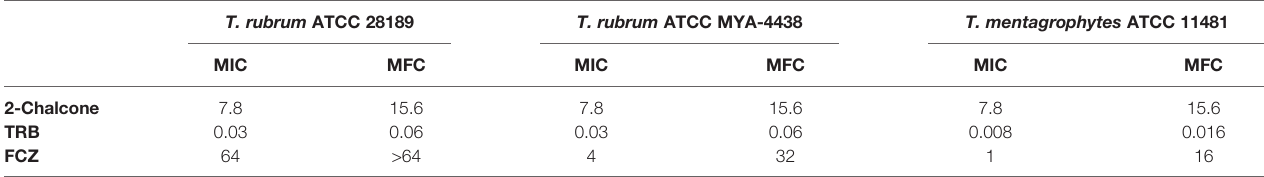
TABLE 1 | Antifungal activity (expressed in mg/L) of 2-chalcone, terbina fi ne, and fl uconazole against dermatophyte species. T. rubrum ATCC